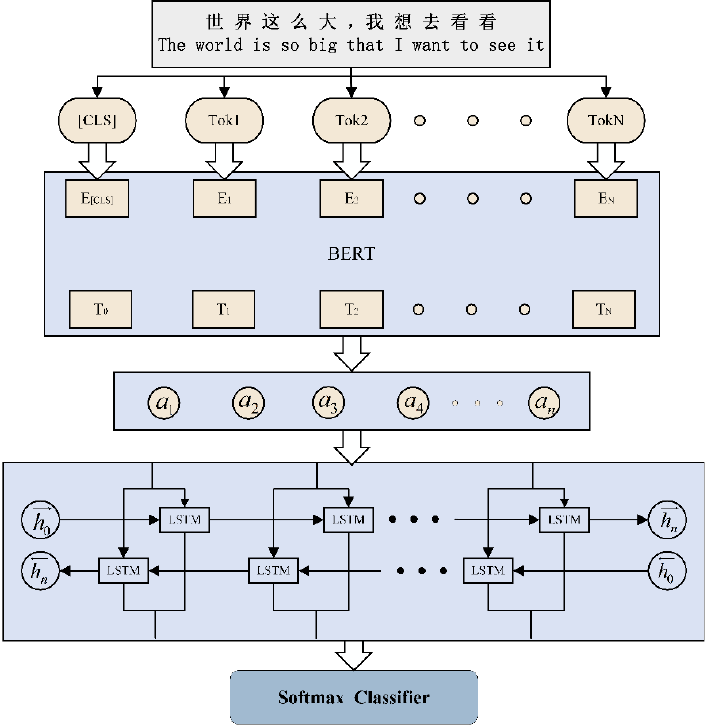
Figure 6. Structure of BERT – BiLSTM network buzzwords.